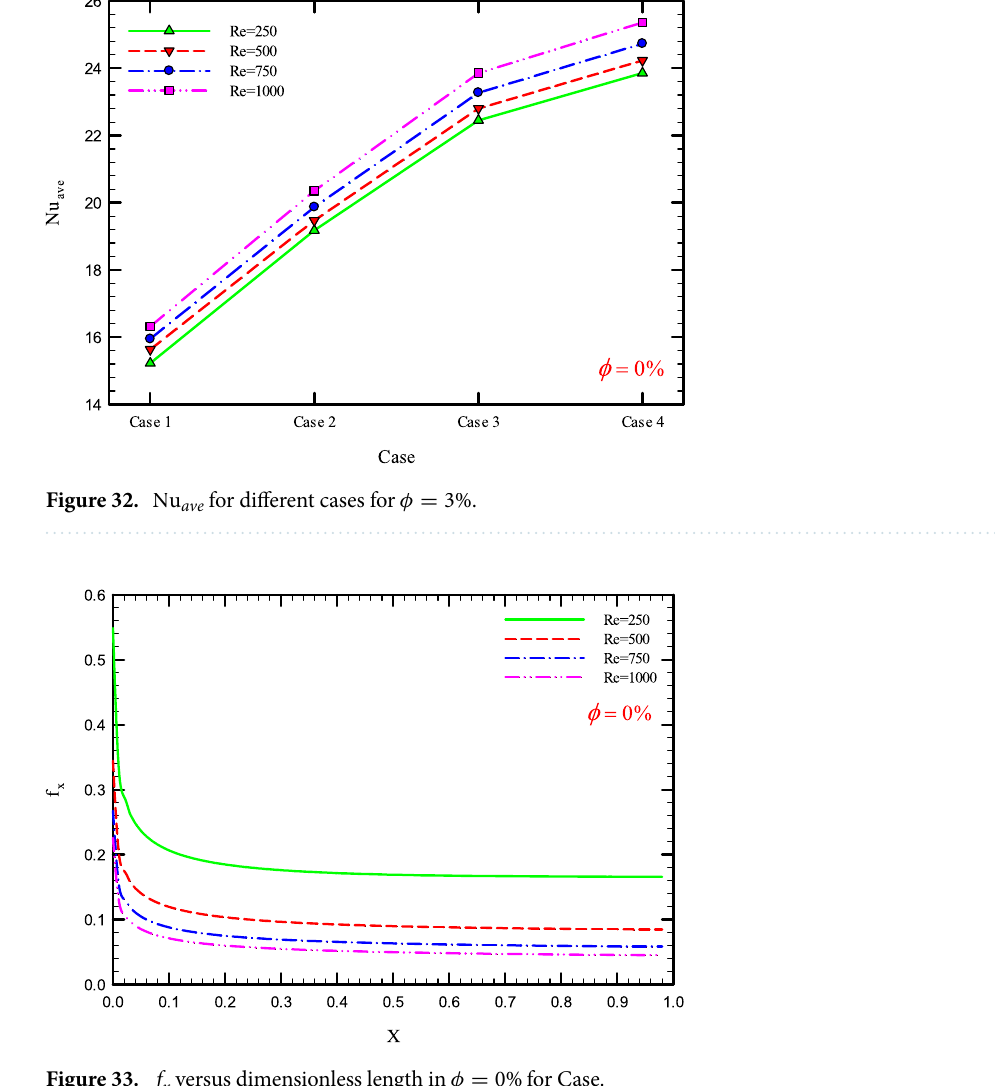
Figure 33. f x versus dimensionless length in φ = 0% for Case.